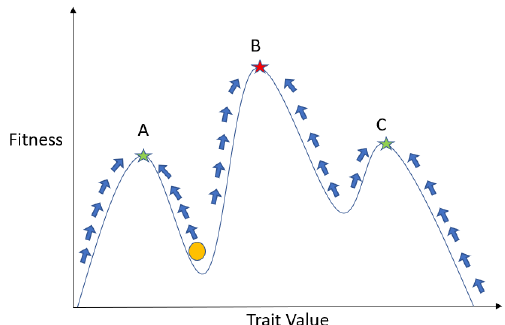
Figure 2. Example snapshot of adaptive landscape. This figure depicts a temporal snapshot of a possible adaptive landscape. The x -axis represents the trait value under consideration and the y -axis represents the fitness of the individual. The adaptive landscape then depicts the fitness conferred to an individual adopting a given trait value at a given time. In reality, adaptive landscapes are highly dynamic, changing in response to species’ population sizes and strategy